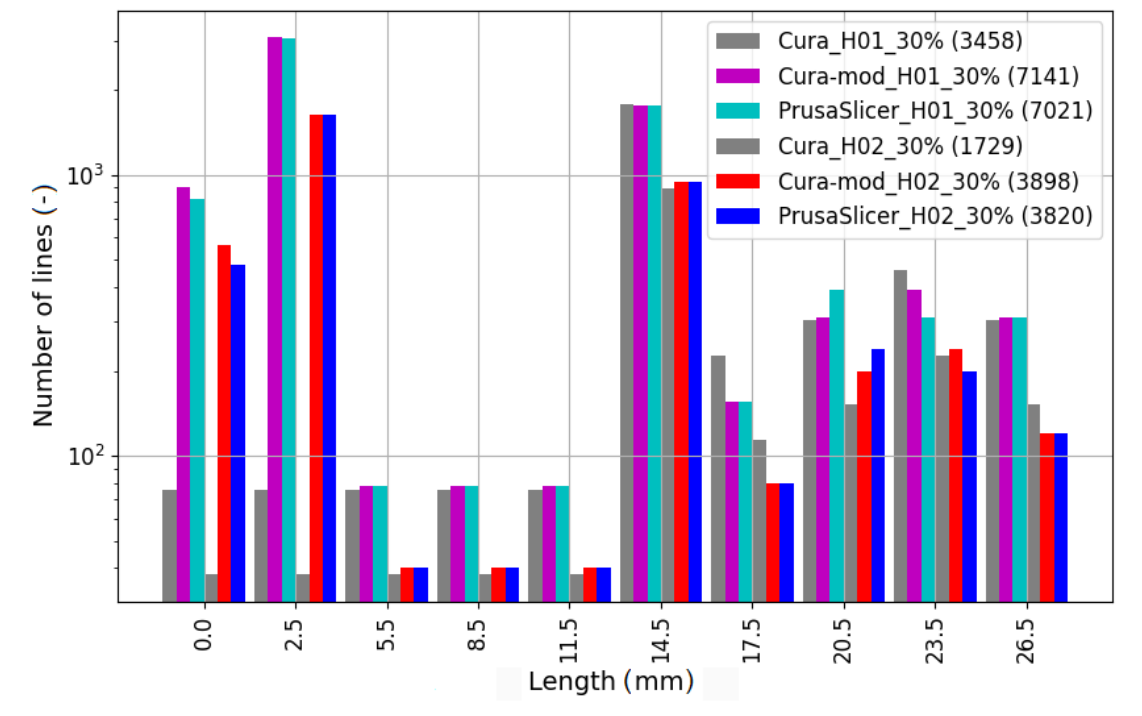
Figure 15. Length of the